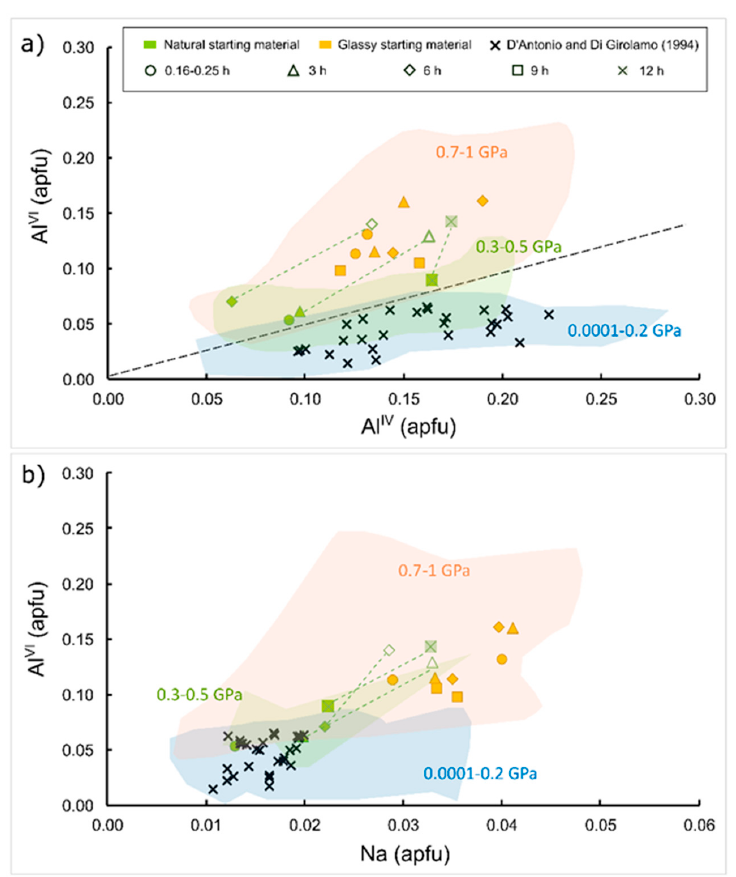
Figure 3. Al IV vs Al VI ( a ) and Na vs Al VI ( b ) diagrams. Literature data (black crosses) are from D’Antonio and Di Girolamo [58]. The new forming Cpx can be distinguished from the pre-existing nuclei: the former fall in the high-pressure field ( P > 0.7 GPa), while the latter in the low pressure one ( P ≤ 0.5 GPa). The black dotted line bounding the fields of high ‐ low pressure Cpx is an arbitrary limit drawn on the basis of results of experiments on APR16 composition at 0.2, 0.4 (low ‐ P field) and 0.8 GPa (high ‐ P field) [32].The green dotted lines, instead, connect Cpx core and rim. Series are indicated with different colors: green for natural starting material, and yellow for glassy starting material. The duration of each run is indicated with different symbols: circle for 0.16 and 0.25 h runs, triangle for 3 h runs, diamond for 6 h runs, square for 9 h runs and square with internal cross for 12 h run. In natural starting material series empty symbols indicate Cpx rim, while full symbols indicate Cpx cores. Colored field represents literature experimental data [32]. Error bars are smaller than symbol size.